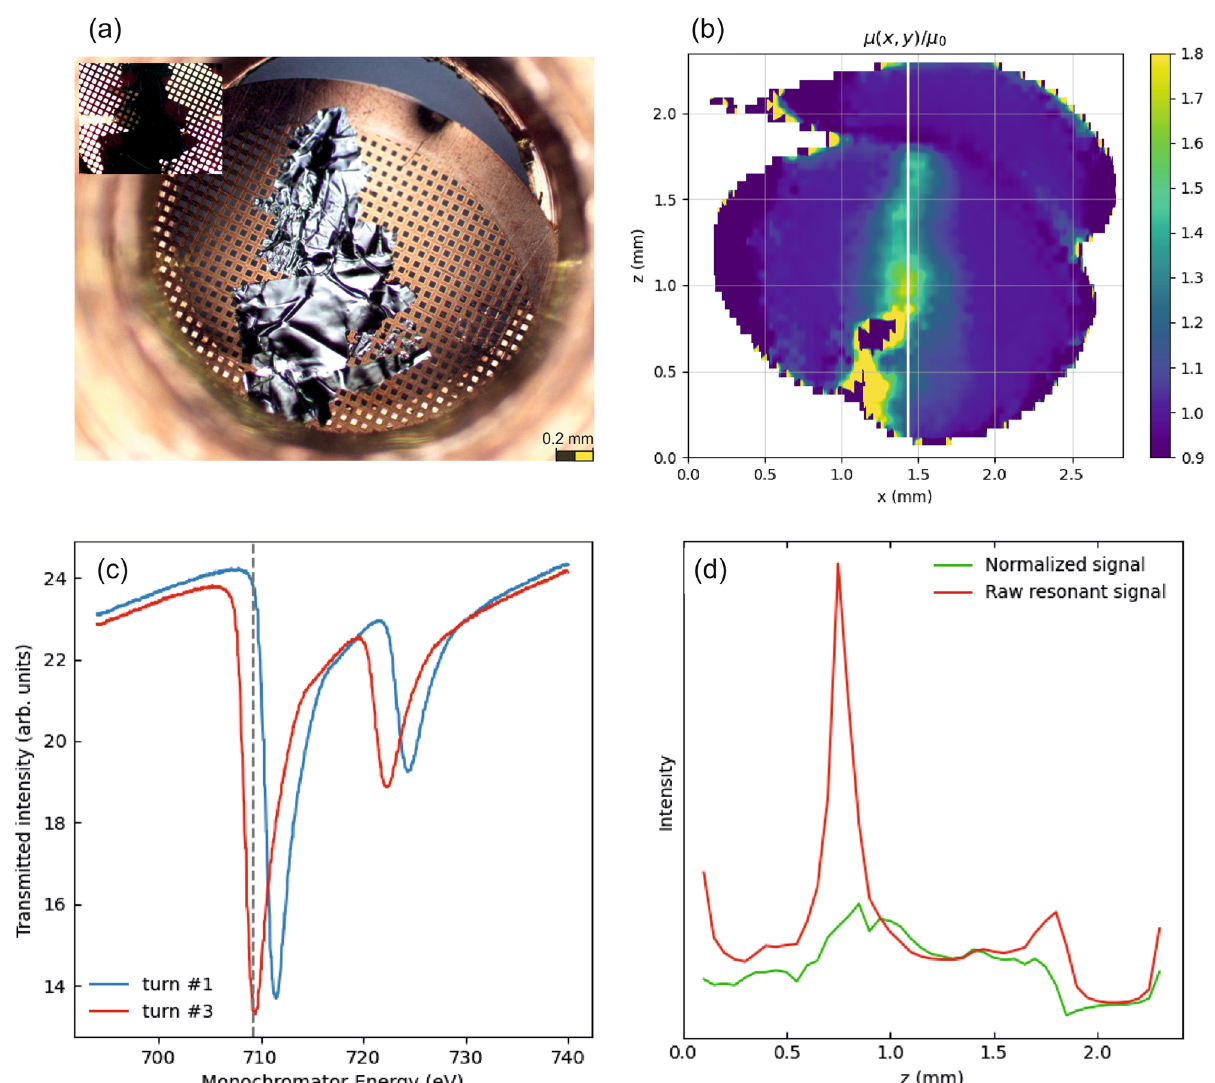
Figure 3. Images, spectra and analysis from a dichalcogenide Fe 3 GeTe 2 thin film sample. ( a ) Visible light microscope image of the free standing thin film in reflection and a close up in transmission in the inset. ( b ) A transmission X-ray image as normalized turn by turn (turn #3/turn#1) at 709 eV. ( c ) Corresponding absorption spectra integrated over the full field across the Fe L-edges. ( d ) Raw intensity signal behind the sample at 709 eV along the vertical white line of the full map in ( b ) without (red) and after (green) turn-by-turn normalization (#1/#3) that eliminates the thickness contrast according to Lambert–Beer’s law, which fully dominates the raw signal (red). For detailed analysis of the maps and the line scan see Supplementary Note